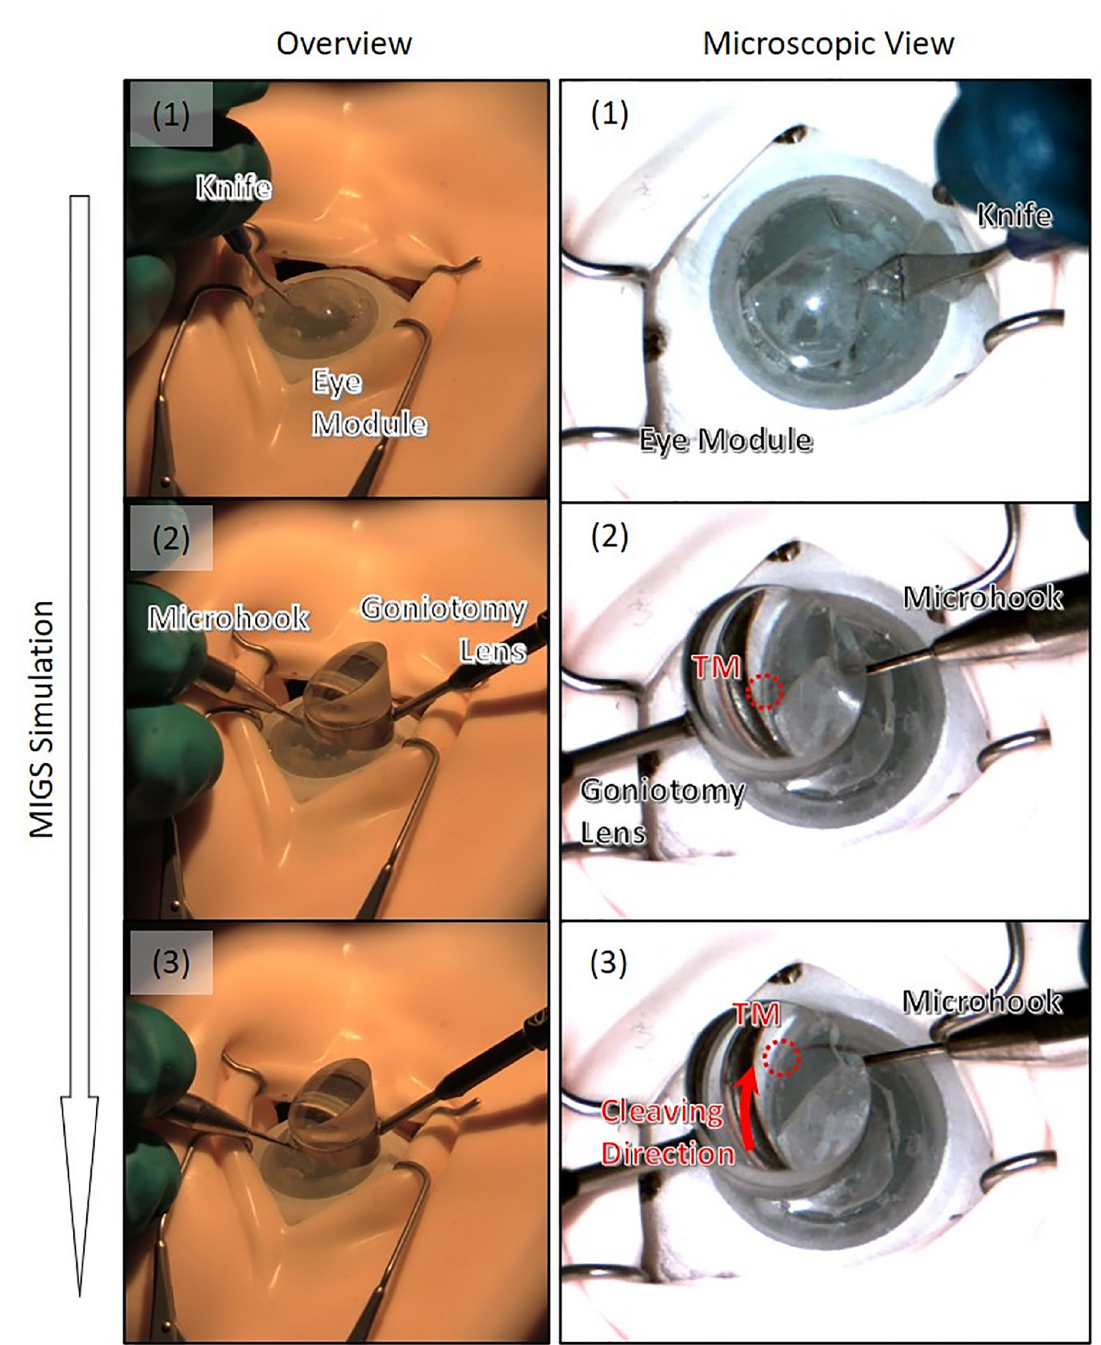
Fig 7. Snapshots of the MIGS procedure. (1) Making a small hole in the cornea by incising it. (2)(3) Cleaving the TM membrane in the eye module.